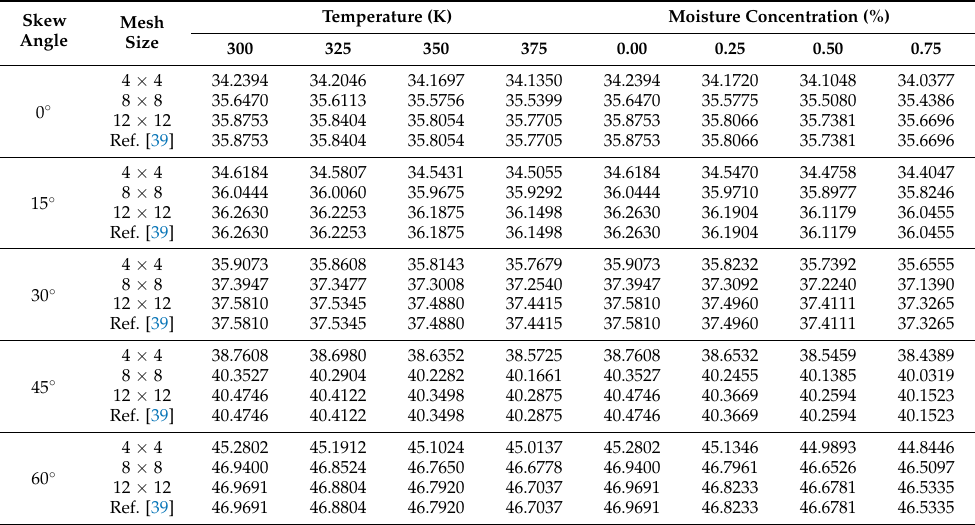
Table 3. Influence of hygrothermal environment on the non-dimensional frequency of the clamped skew composite